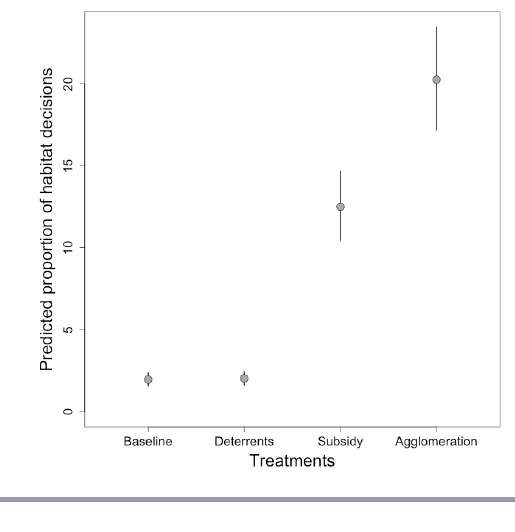
Fig. 6. Predicted proportion (%) of farmers’ decisions to provide habitats in each treatment. Predicted values computed from the reduced model (Table 3) are shown for the average household and group. Error bars are 0.95 quantiles of the bootstrapped distributions.